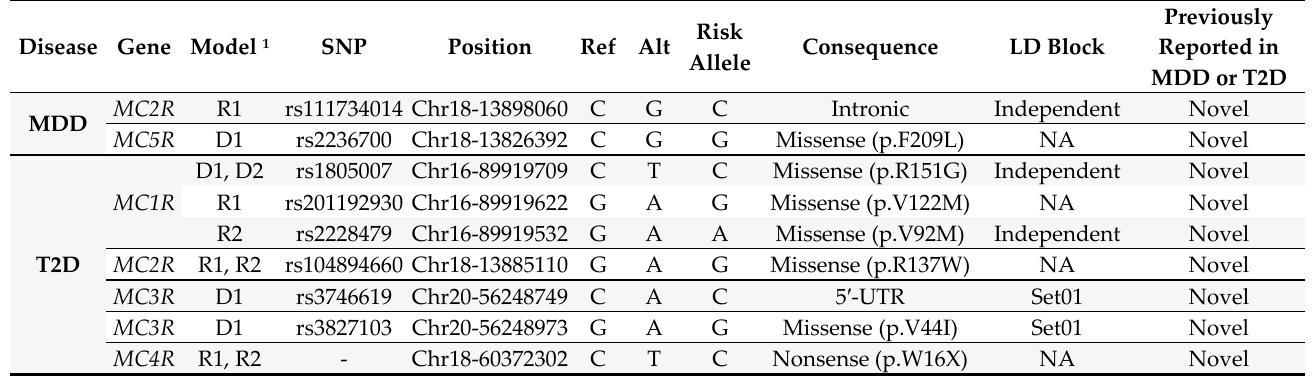
Table 1. Melanocortin Receptor Genes: Risk SNPs for MDD and T2D.